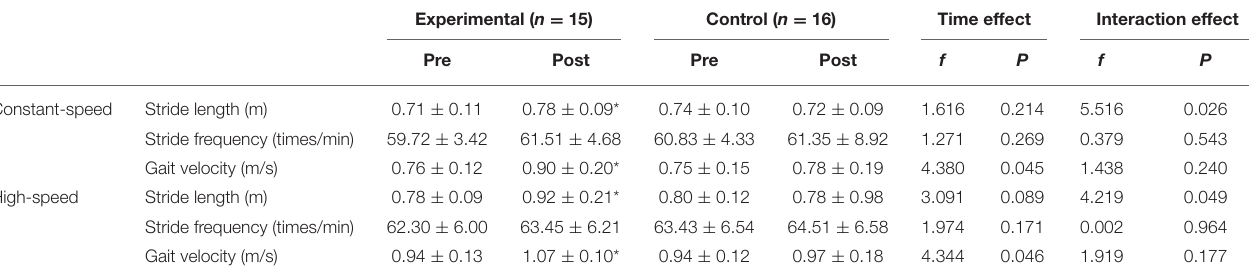
TABLE 2 | Gait outcome measures before and after 12 weeks of